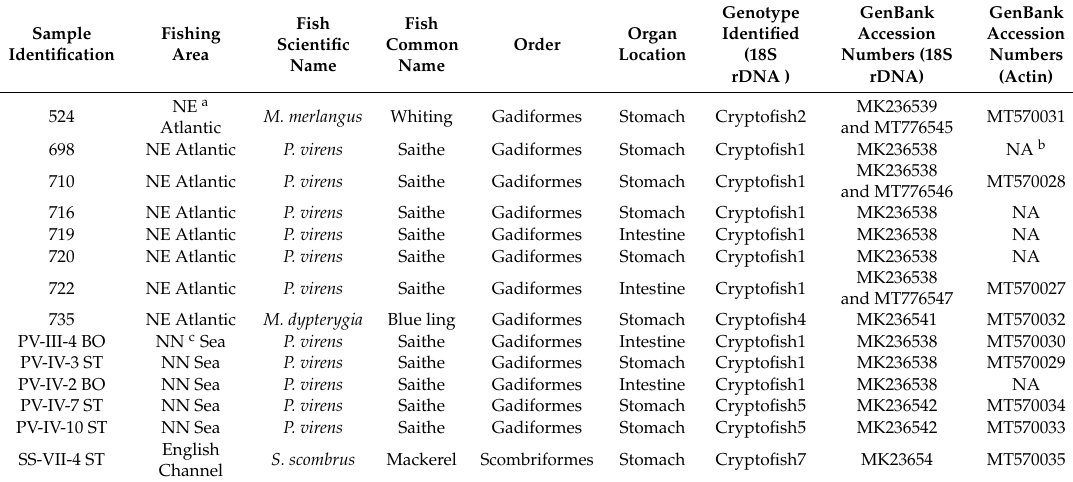
Table 1. Details of Cryptosporidium piscine isolates typed at the 18S locus in a previous study and re-amplified and sequenced at the 18S rDNA and actin loci for the present